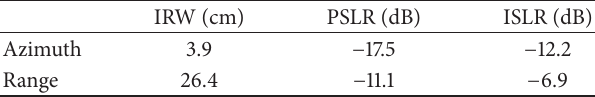
Table 3: MIMO SAR performance for imaging results.